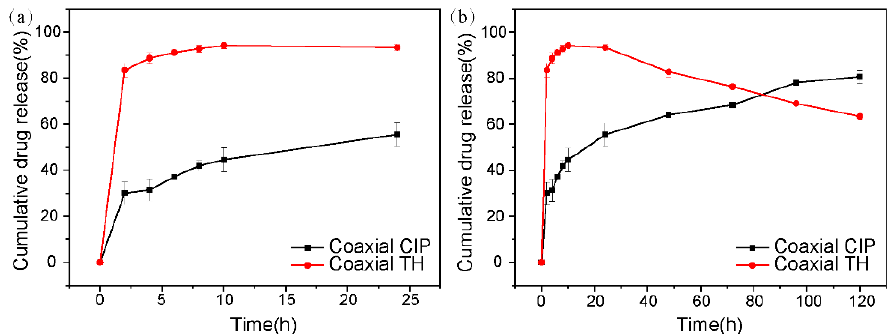
Figure 4. In vitro drug release of CIP and TH at different periods. ( a ) 24 h; ( b ) 120 h.